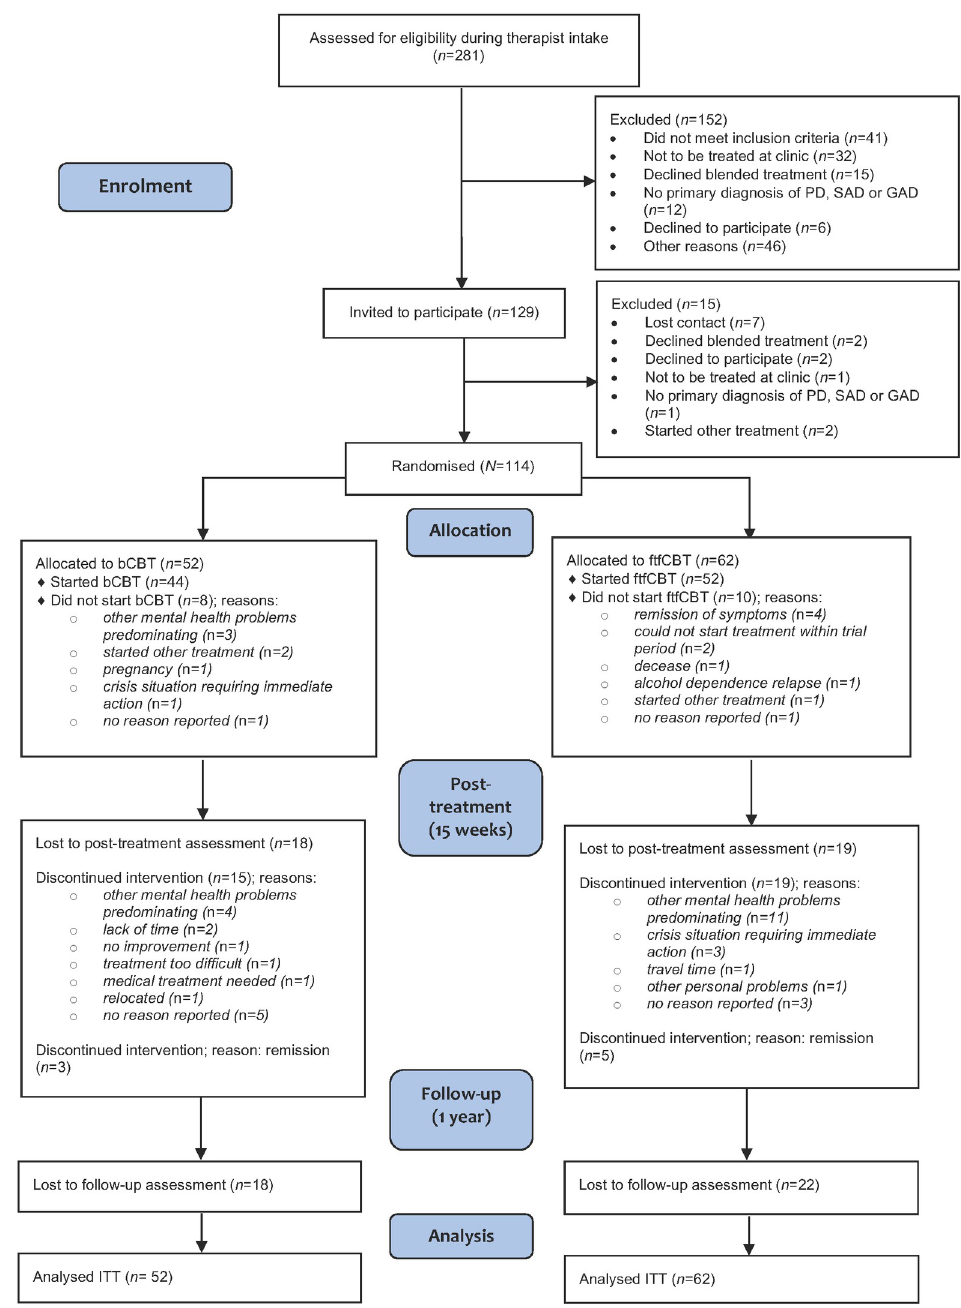
Fig 1. CONSORT flow diagram of